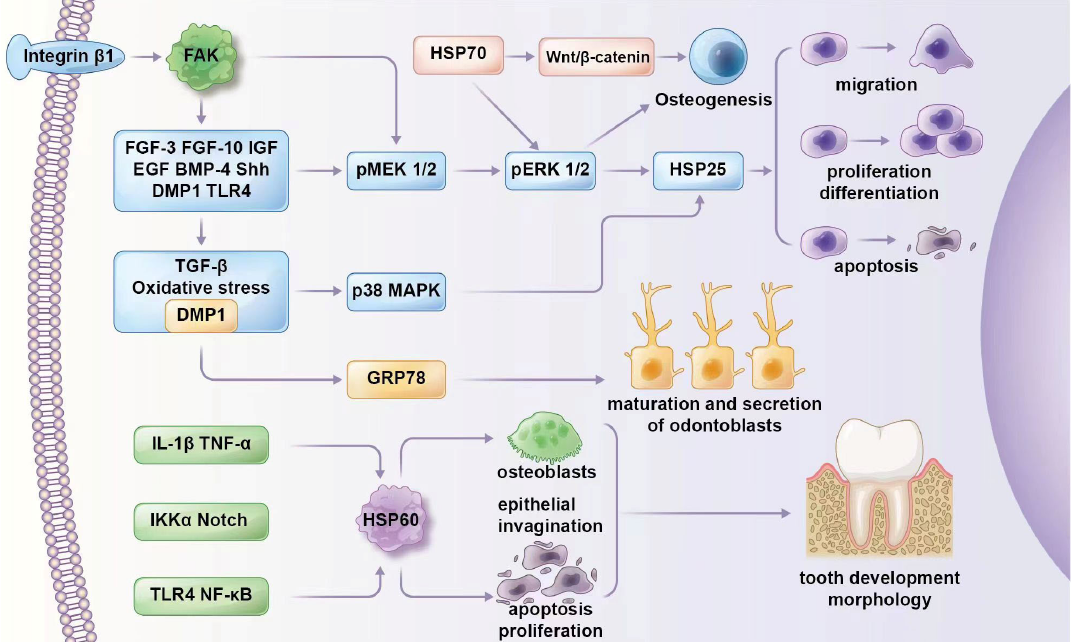
Figure 5. Signal pathways that HSPs may participate in tooth development and damage repair. HSP25 can promote cell migration, proliferation, and di ff erentiation and inhibit apoptosis in the MAPK pathway. HSP70 and ERK participate in the process of osteogenesis. GRP78 and DMP1 promote the maturation and secretion of odontoblasts. HSP60 may a ff ect tooth development and morphology by a ff ecting epithelial invagination, as well as the proliferation and apoptosis of osteoclasts and tooth germ cells.